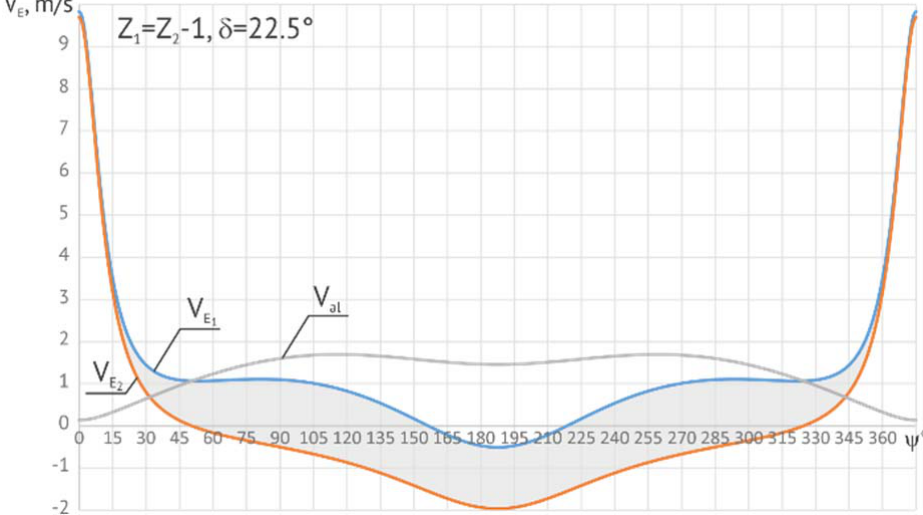
Figure 7 . The relative sliding speed V =Z -1 (precessional gear Z for Z 1 2